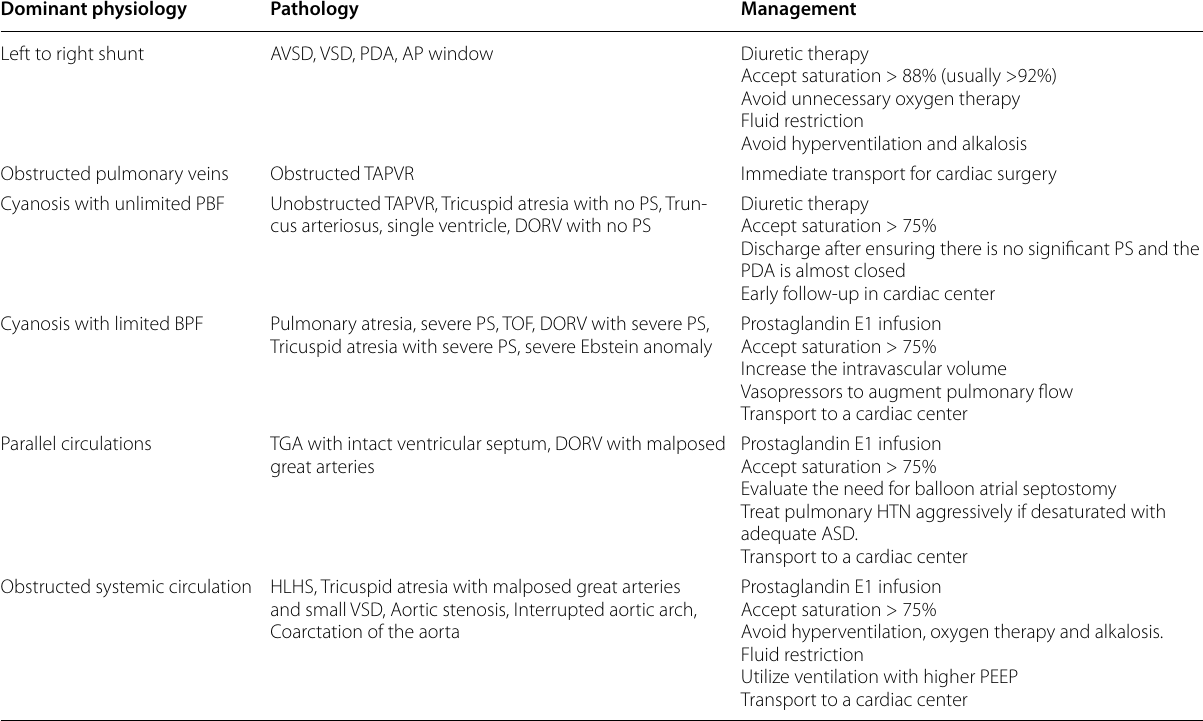
AVSD Atrioventricular septal defect, VSD Ventricular septal defect, PDA Patent ductus arteriosus, AP window Aorto-pulmonary window, TAPVR Total anomalous pulmonary venous return, PBF Pulmonary blood flow, PS Pulmonary stenosis, DORV Double outlet right ventricle, TOF Tetralogy of Fallot, TGA Transposition of